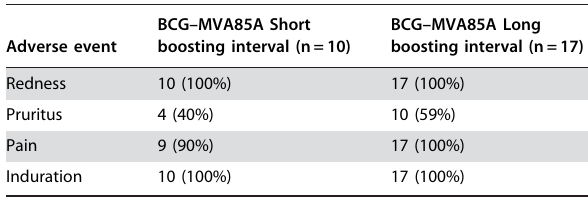
Table 2. Local adverse events after MVA85A vaccination .. ... .... ... ... .... ... ... .... ... ... .... ... ... .... ... ... .... ... ... .... .